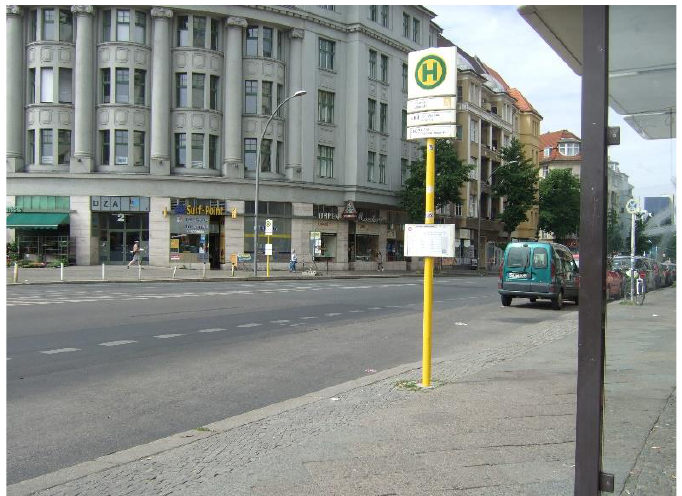
Figure 3. Bus stop.